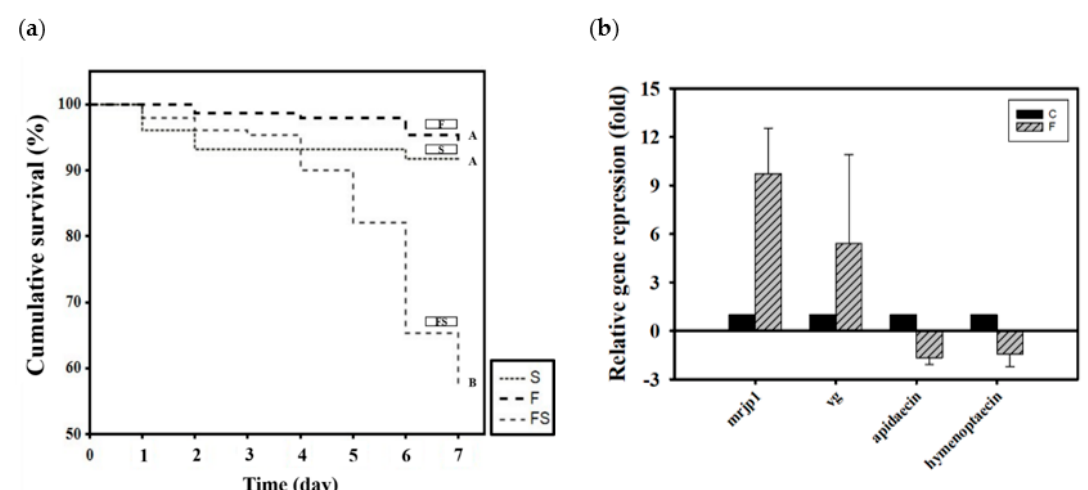
Figure 2. The effect of CK-CsC SYM fermentation broth on honey bees. ( a ) The cumulative survival of honey bees after 6-day feeding treatments. New emerged bees in groups of 50 bees fed with 50% sucrose syrup (S), CK-CsC SYM fermentation broth (F) and supernatant of CK-CsC SYM fermentation broth (FS). Each point represents the cumulative survival rate (N = 4 cages from four colonies). Different letters are significantly different ( p < 0.05) accordingly to the Holm-Sidak test. ( b ) Gene expression profile of honey bees after 6-day feeding treatments. C: control, bees feeding with SYM broth; F: bees feeding with CK-CsC SYM fermentation broth. The relative gene expression was analyzed using the 2 − ∆∆ C T method. Data represent the mean of three repeats, with error bars indicating the standard deviation.